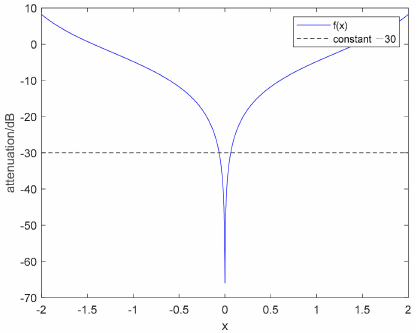
Figure 3. The function curve of f ( x )